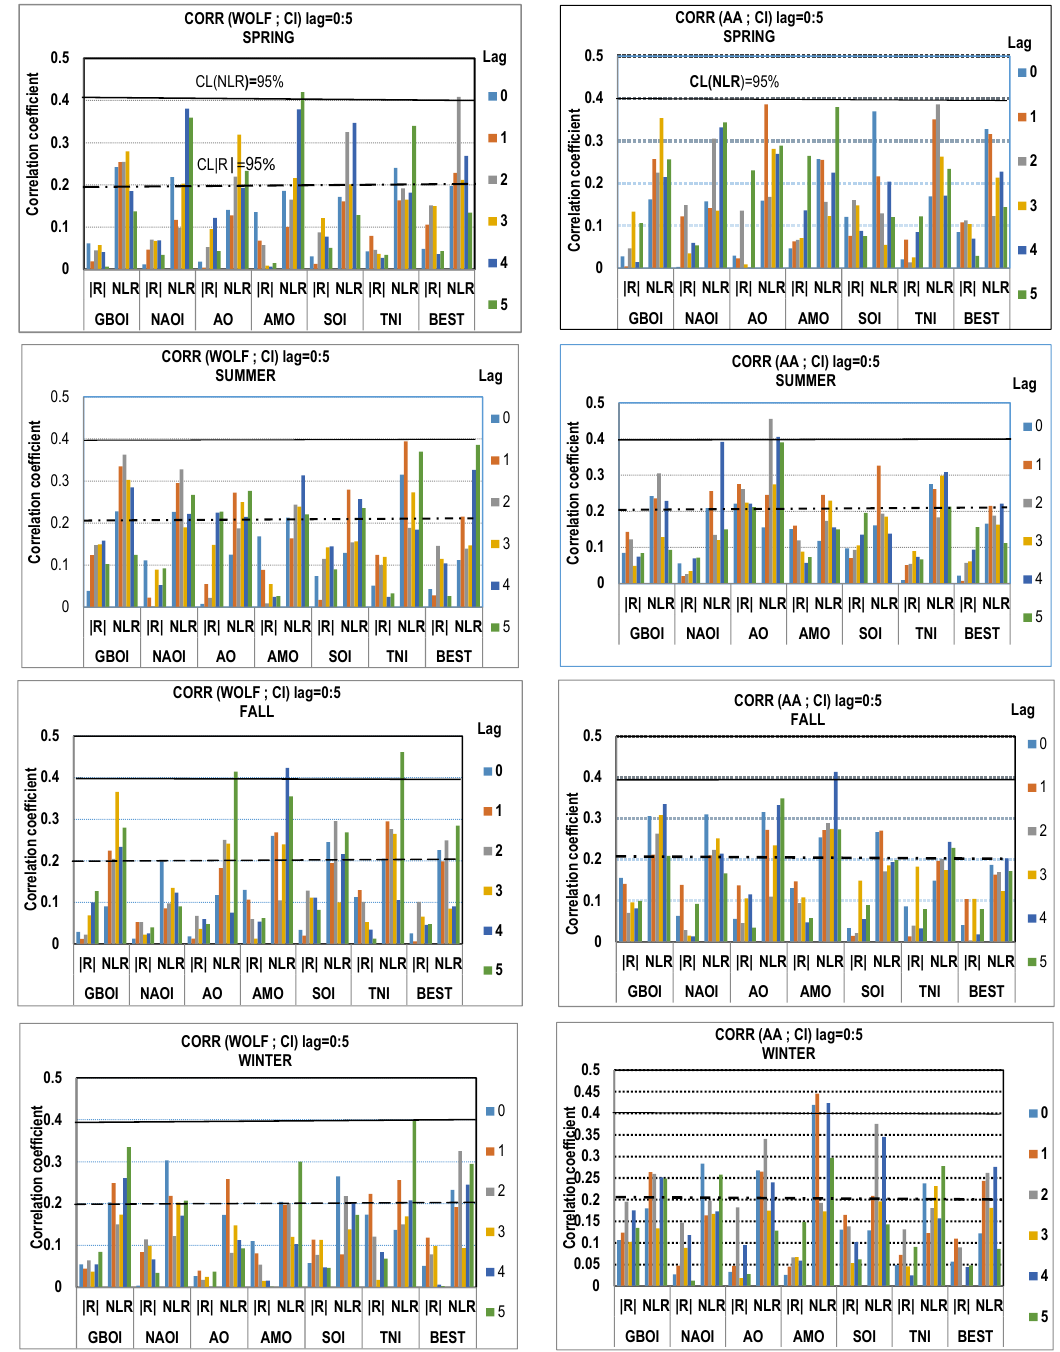
Figure 1. Pearson correlation coefficient |R| in comparison with the NLR correlation coefficient for each season and with lag from 0 to 5 years, between the Wolf number and the climate indices ( left ), and the aa geomagnetic index and climate indices ( right ). The 95% confidence level for NLR is represent with the solid lines and for R with dotted one.